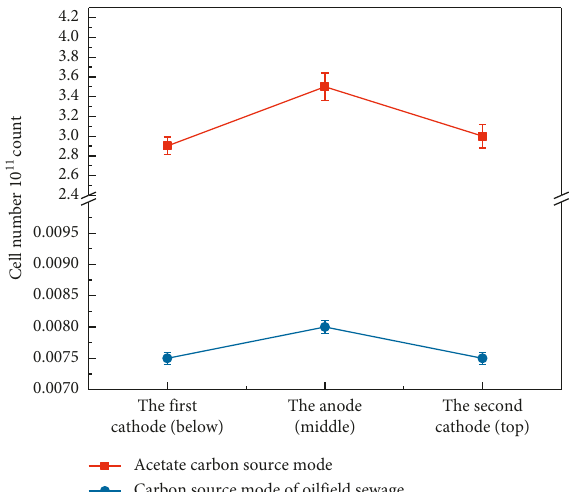
Figure 5: Microbial activity (number of cells).